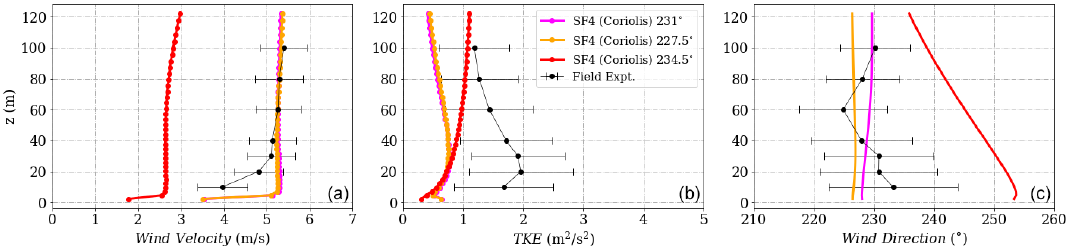
Figure D9. (a) Wind velocity magnitude, (b) wind direction and (c) turbulent kinetic energy at Tower 29 (tse13) for the SF4 (Coriolis) model.